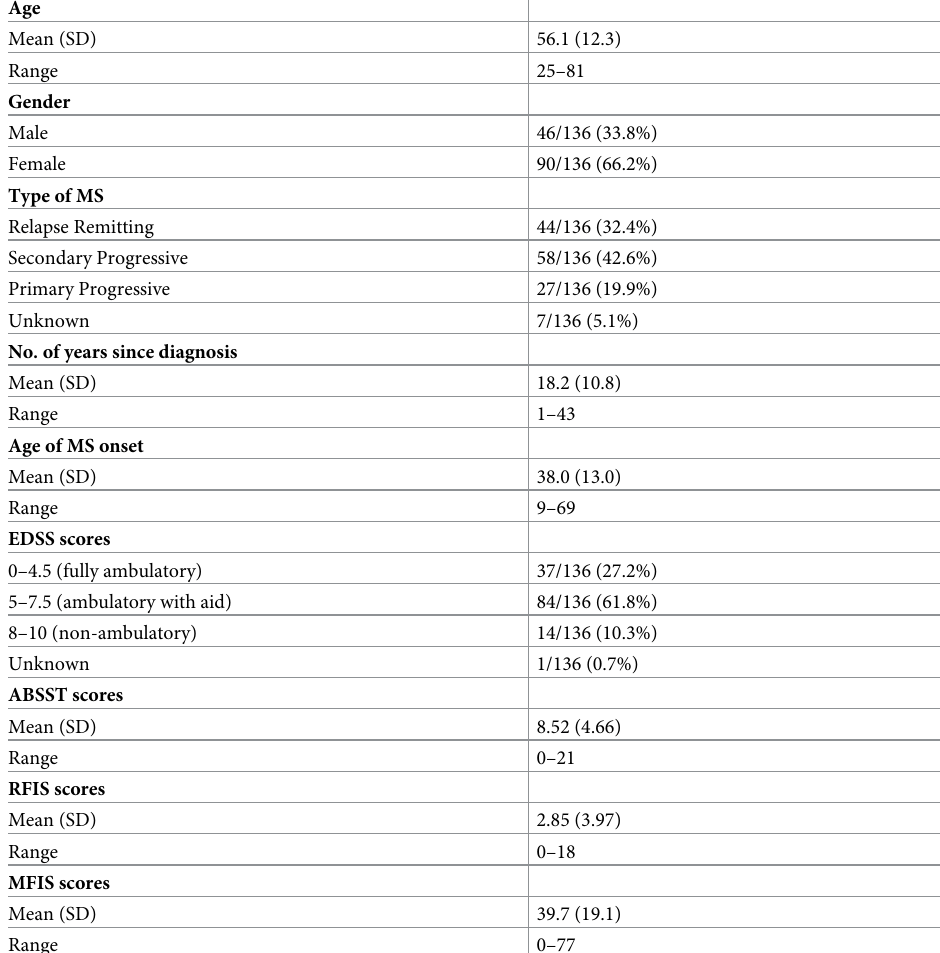
Table 1. Demographic information and baseline clinical characteristics of study population (n = 136). ABSST: Actionable Bladder Symptom Screening Tool [19]; EDSS: Expanded Disability Status Scale [17]; MFIS: